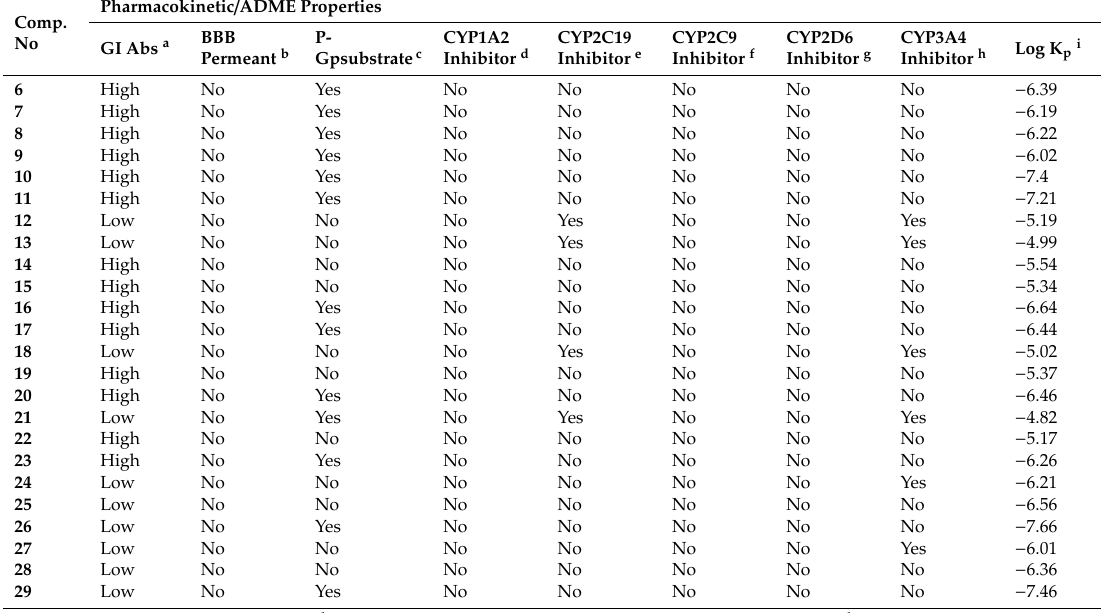
Table 2. Pharmacokinetic / ADME (absorption, distribution, metabolism and excretion) properties of the selected compounds 6–29